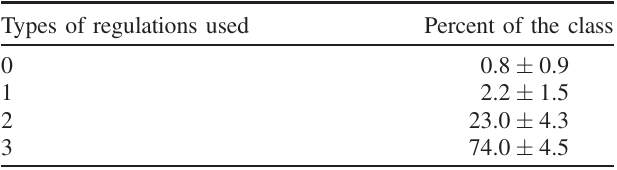
in zero, one, or multiple of the regulation types: socially shared, self-, and co- to overcome their teamwork challenges. The error is given by a 95% binomial confidence interval.